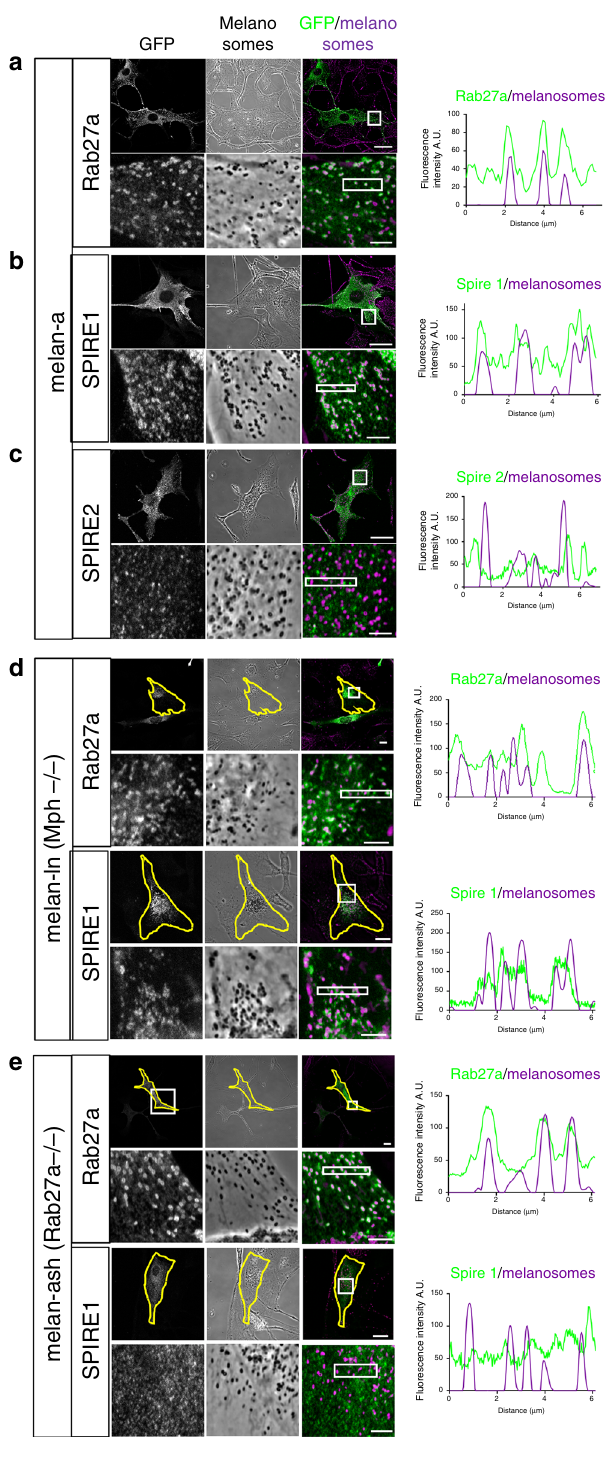
Based on these fi ndings, we propose a model by which this might occur (Fig. 9). Firstly, we suggest that Rab27a-GTP recruits two effector complexes to melanosomes; (i) myosin-Va/melano- philin and (ii) SPIRE1/2 (Fig. 9a). The recently identi fi ed myosin- Va:SPIRE1/2 interaction may also stabilise SPIRE1/2 at the melanosome membrane and/or integrate SPIRE1/2 activity with myosin-Va 38 . We expect that the recruitment of two effector complexes requires two pools of Rab27a, as the Rab27 interaction domain of SPIRE1/2 appears conserved with other effectors, e.g.,